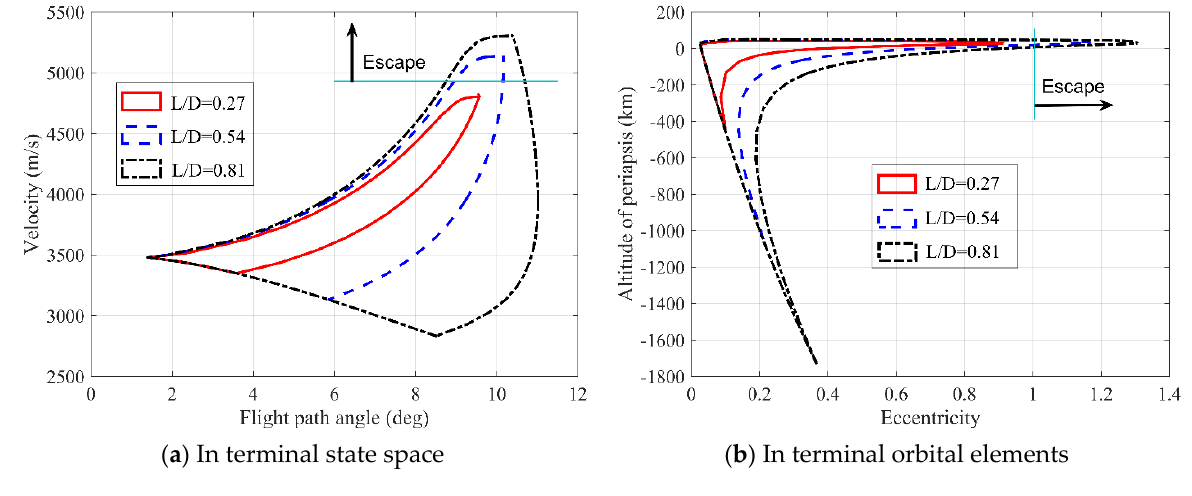
Figure 11. Aerocapture attainability sets with different hypersonic lift–drag ratios.